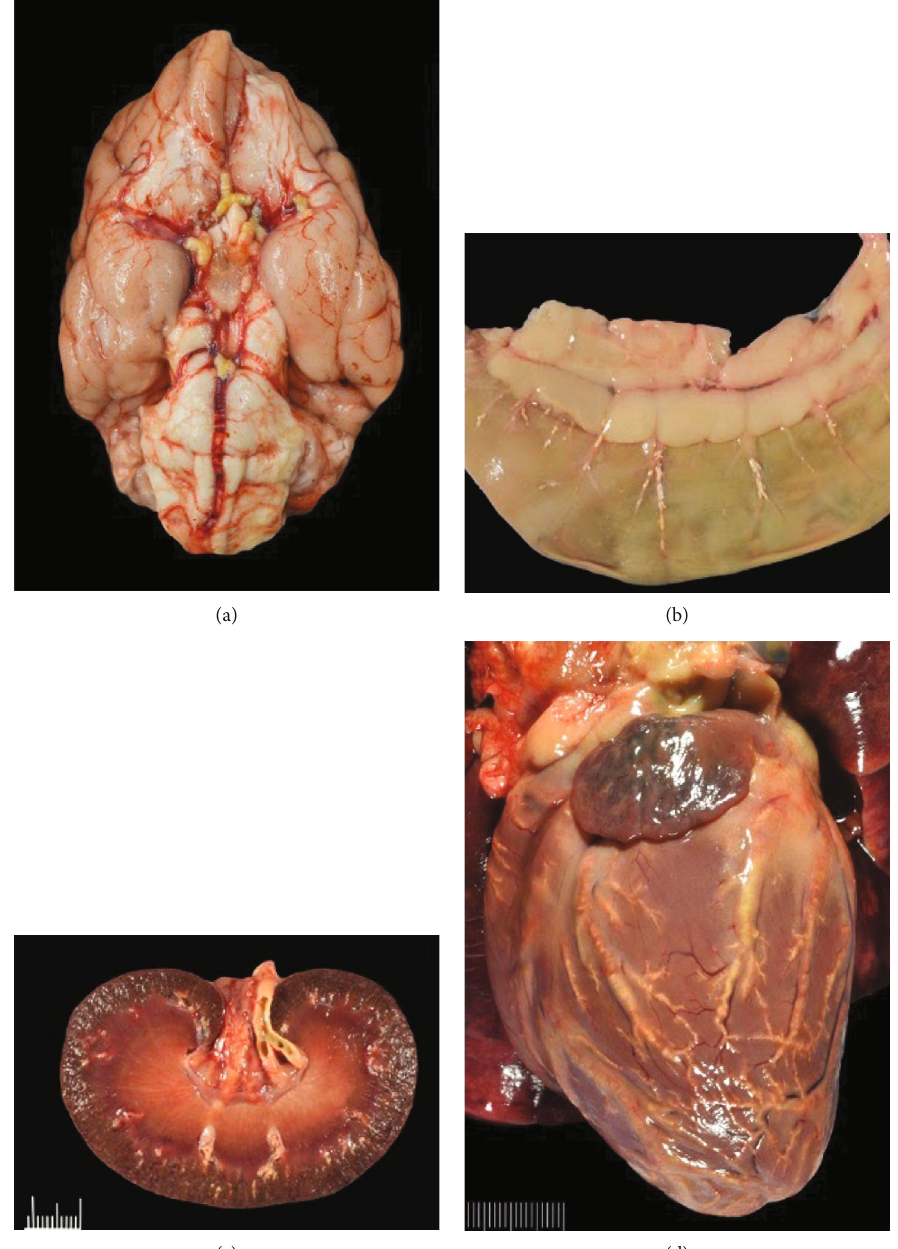
Figure 3: Marked atherosclerotic changes of multiple organs including the (a) brain, (b) gastrointestinal tract, (c) kidney, and (d)